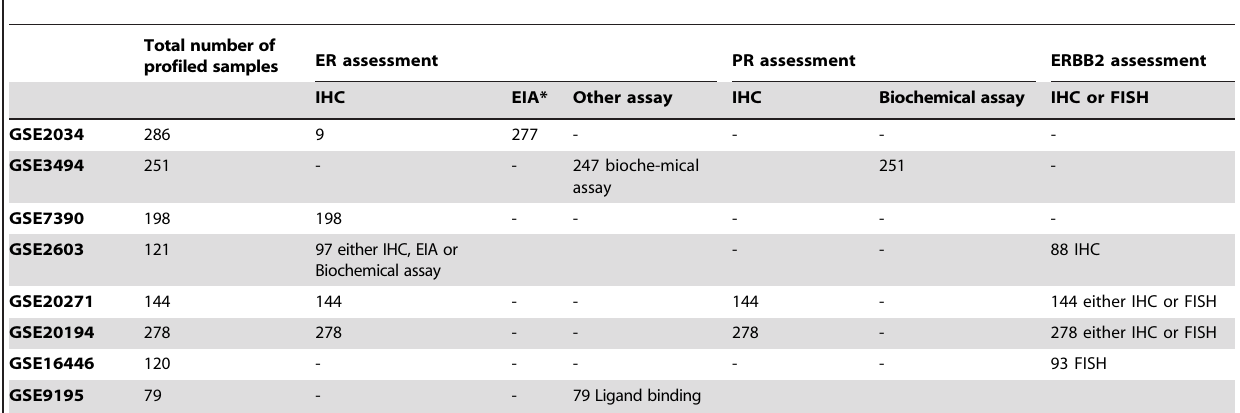
Table 7. Sources of the samples and methods used to obtain the clinical information about the